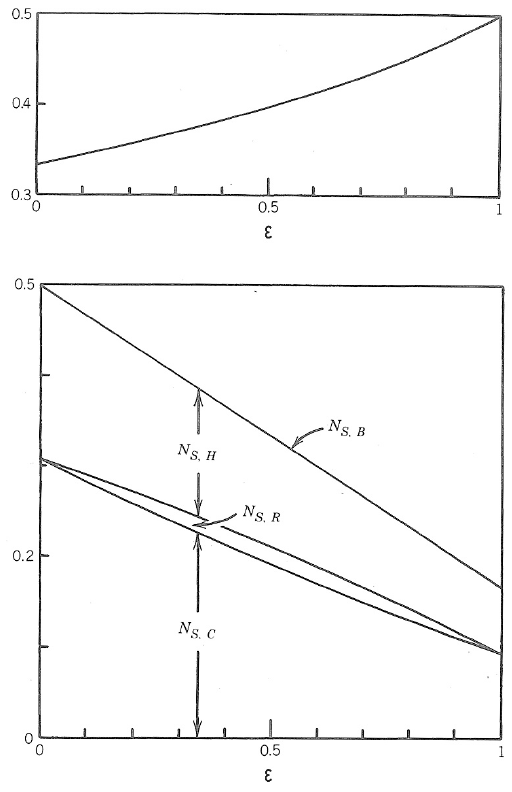
Figure 16. The Brayton cycle power plant (Figure 6, middle) has three heat exchangers [heater (H), counterflow (R), and cooler (C)], and each generates entropy (N S ). The total rate of entropy generation of the Brayton power plant (N S,B ) decreases monotonically as the size of the counterflow (or ε ) increases [21,148].